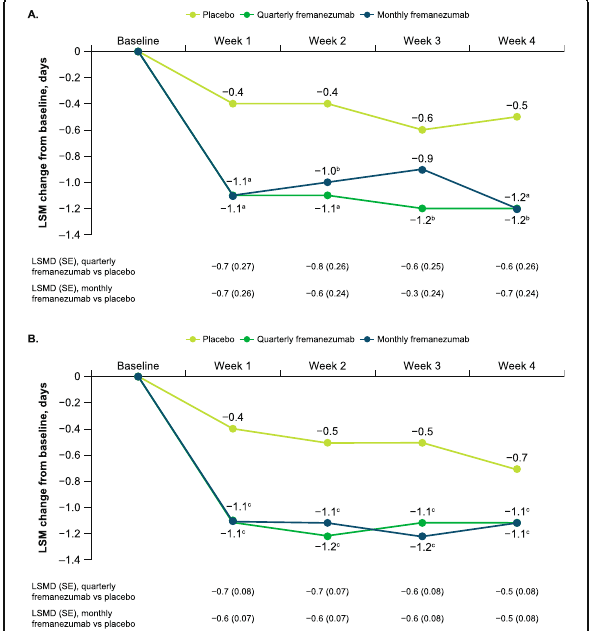
Fig. 3 Change in monthly headache days during 12 weeks A ) overall and B ) by migraine classification. LSM, least-squares mean; LSMD, least-squares mean difference; SE, standard error. Data shown are the LSM changes from baseline in the monthly average number of headache days of at least moderate severity during 12 weeks of double-blind treatment. Part A includes data for participants ≥ 60 years and the overall pooled population; part B includes data for participants ≥ 60 years by migraine diagnosis (chronic or episodic migraine). a P < 0.05 vs placebo. b P < 0.005 vs placebo. c P < 0.0001 vs placebo